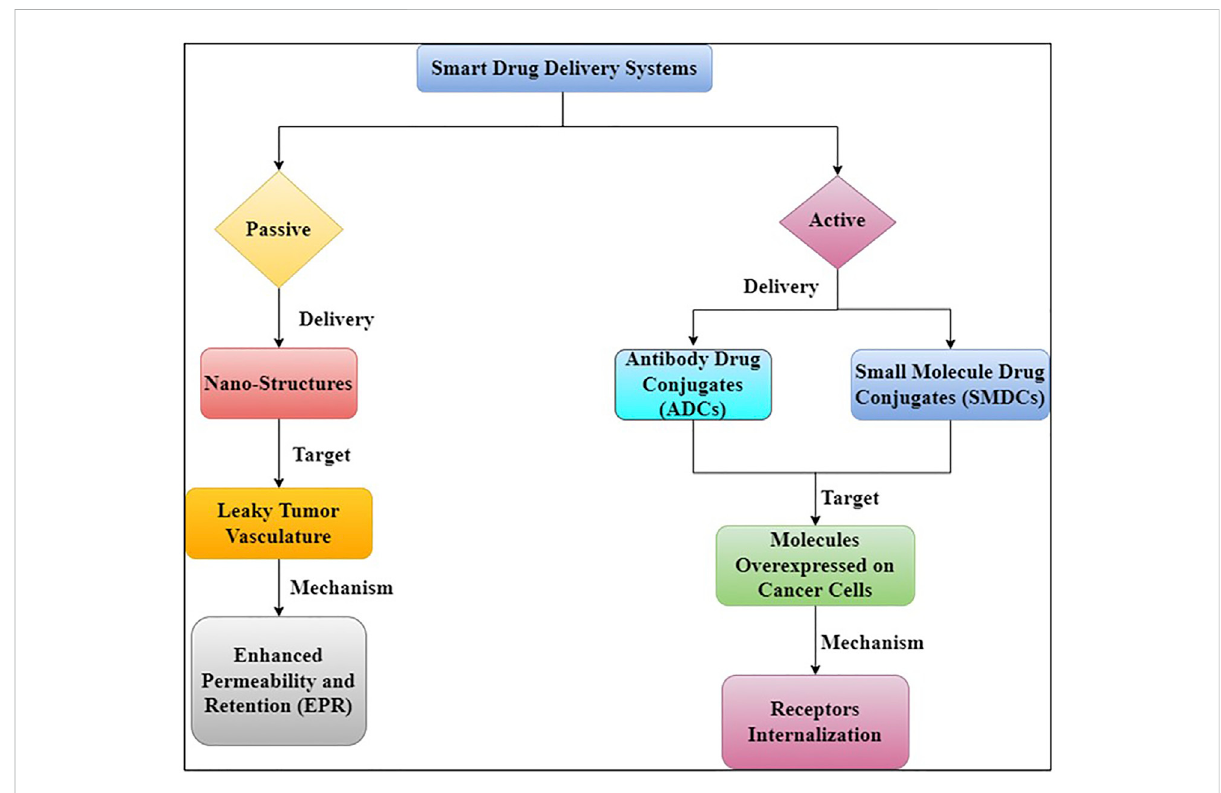
FIGURE 5 Different targeting strategies for anticancer therapeutics.